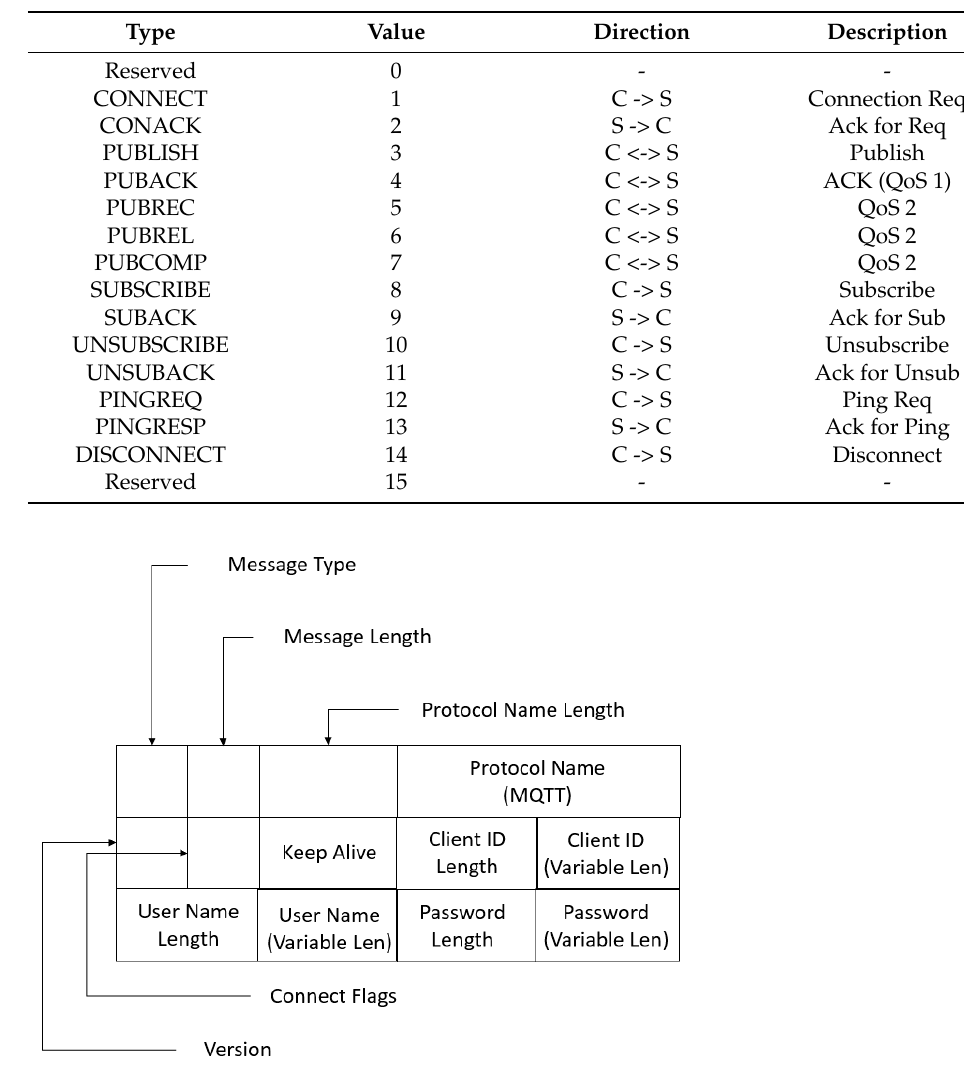
Table 1. MQTT packet types.